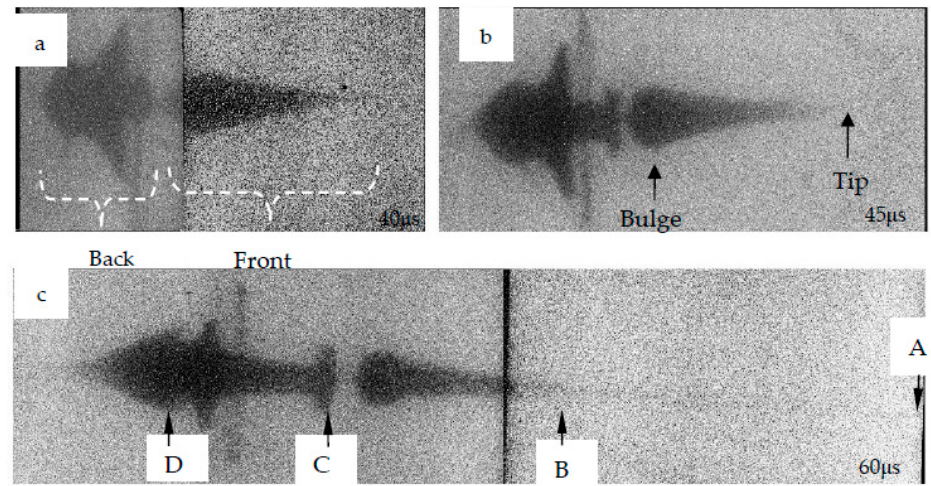
14 of 19 Figure 18. Field arrangement of pulse x-ray photography test and SCS liner. In Figure 18, L H1 represents the distance from the light outlet of the pulse X-ray ma- chine to the charging axis, and L H2 represents the distance from the charging axis to the negative film. Then, the amplification factor K can be obtained, K = (L H1 + L H2) / L H1 . In the test, the exposure delay time of two pulse X-ray machines is set respectively. A metal wire of known length and diameter is placed in front of the negative box as a reference for the jet position. After the test, by measuring the distances from the corresponding positions of the jet on the two X-ray photos to the reference mark line, the movement distance of the corresponding position of the jet in the two exposure times can be calculated, and then the corresponding speed can be obtained. (15) where L H1 is the distance from the corresponding position on the first photo to the refer- ence mark line, L H2 is the distance from the corresponding position on the second photo to the reference mark line, Δ t is the exposure time difference, and K amplification factor.